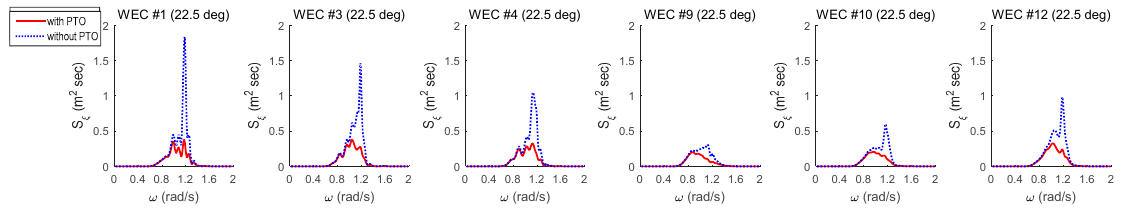
Figure 17. WEC heave motion spectrum for H 1/3 = 1.0 m, T P = 6.67 s, γ = 1.0 in the case of 22.5 deg wave-heading angle.